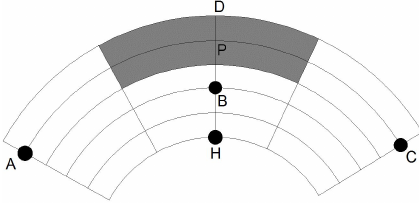
Figure 6: Boundary point of polar